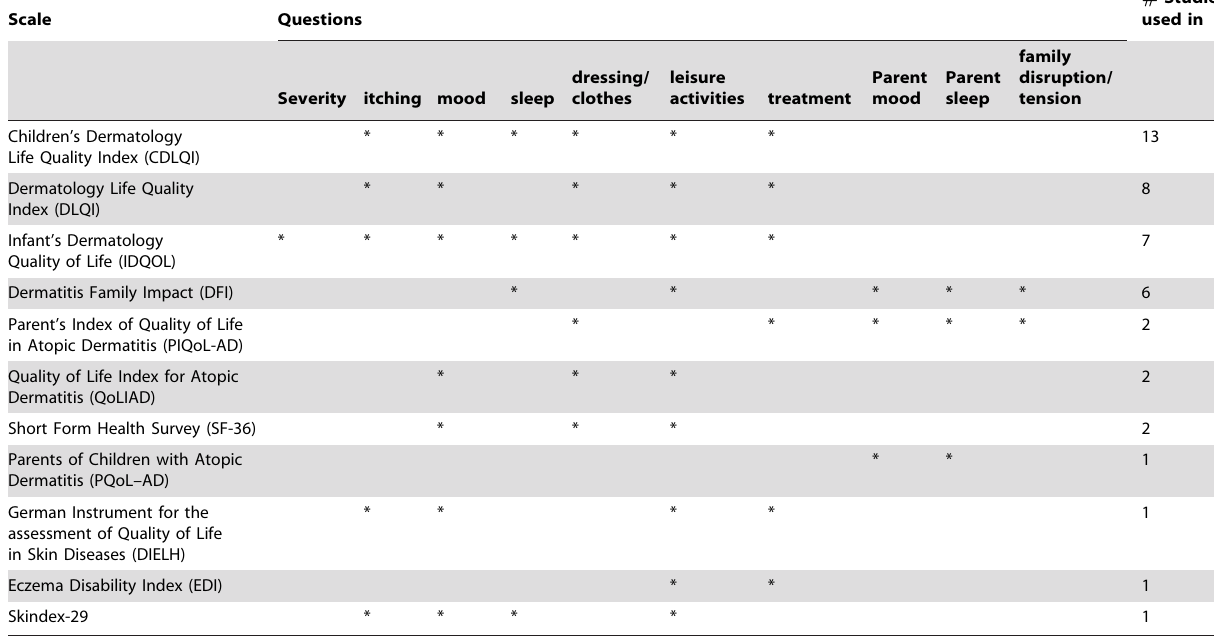
Table 2. Quality of life scales.